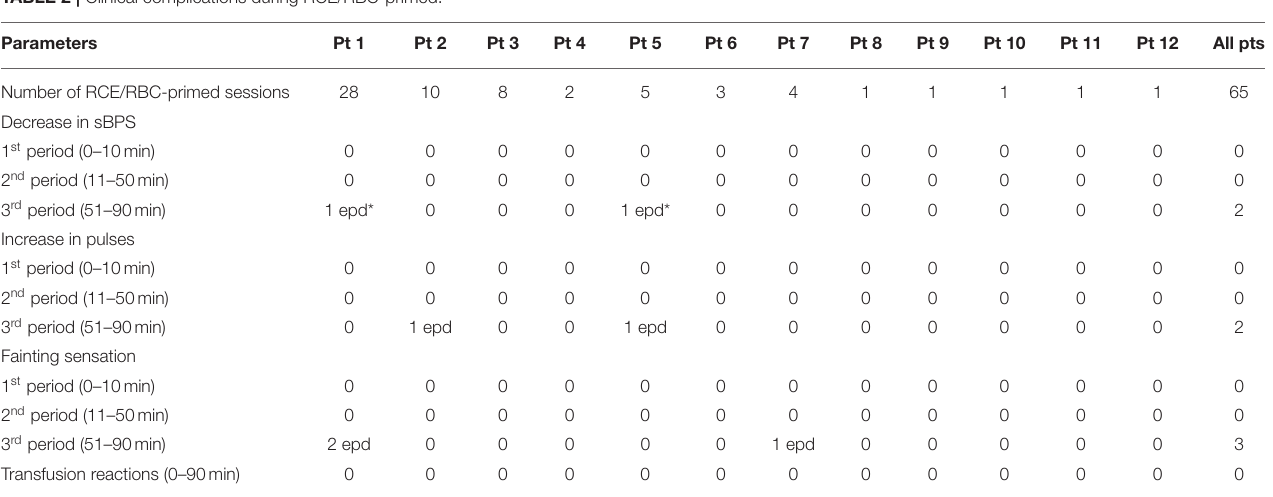
TABLE 2 | Clinical complications during RCE/RBC-primed.